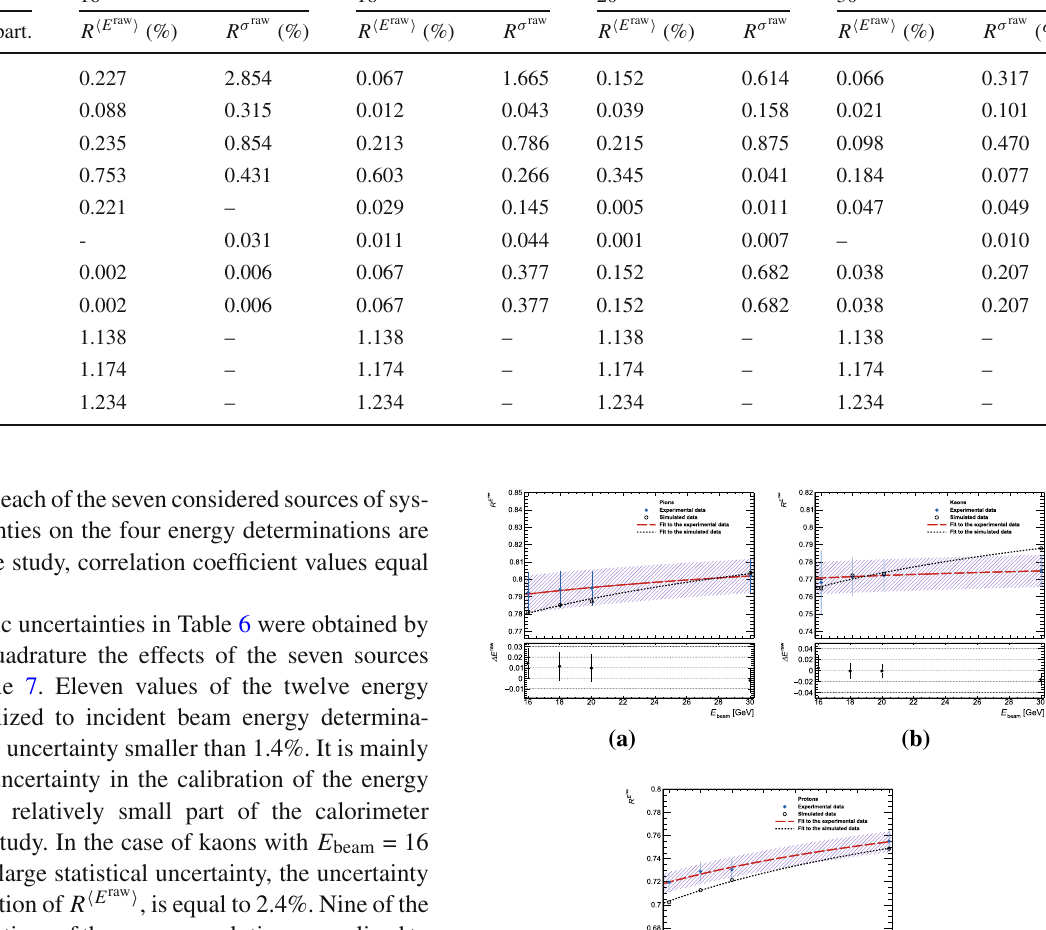
kaon and proton measurements are affected by the uncertainty on the Ch1 (Source 5) and Ch2 (Source 6) selection criteria. The uncertainty